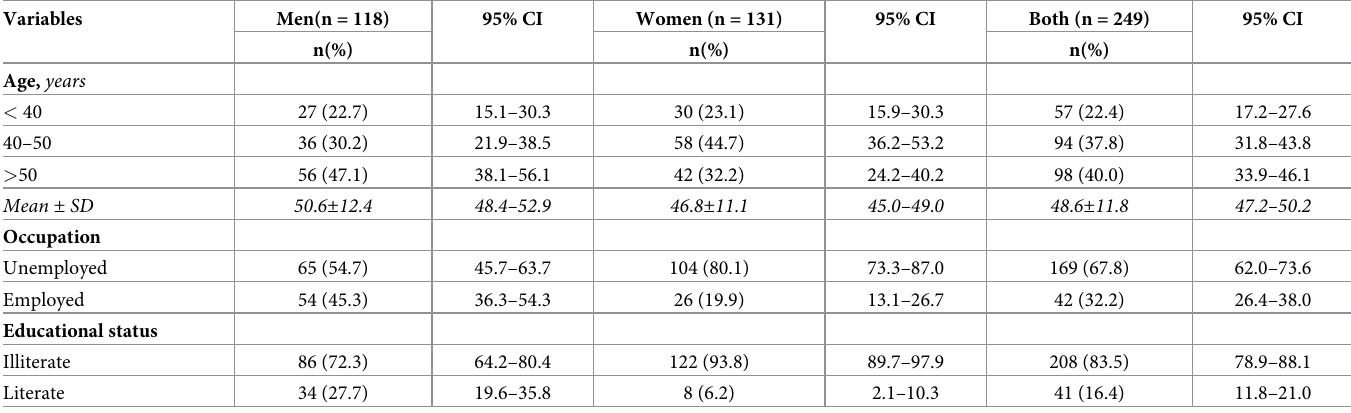
Table 1. Socio-demographic characteristics of the